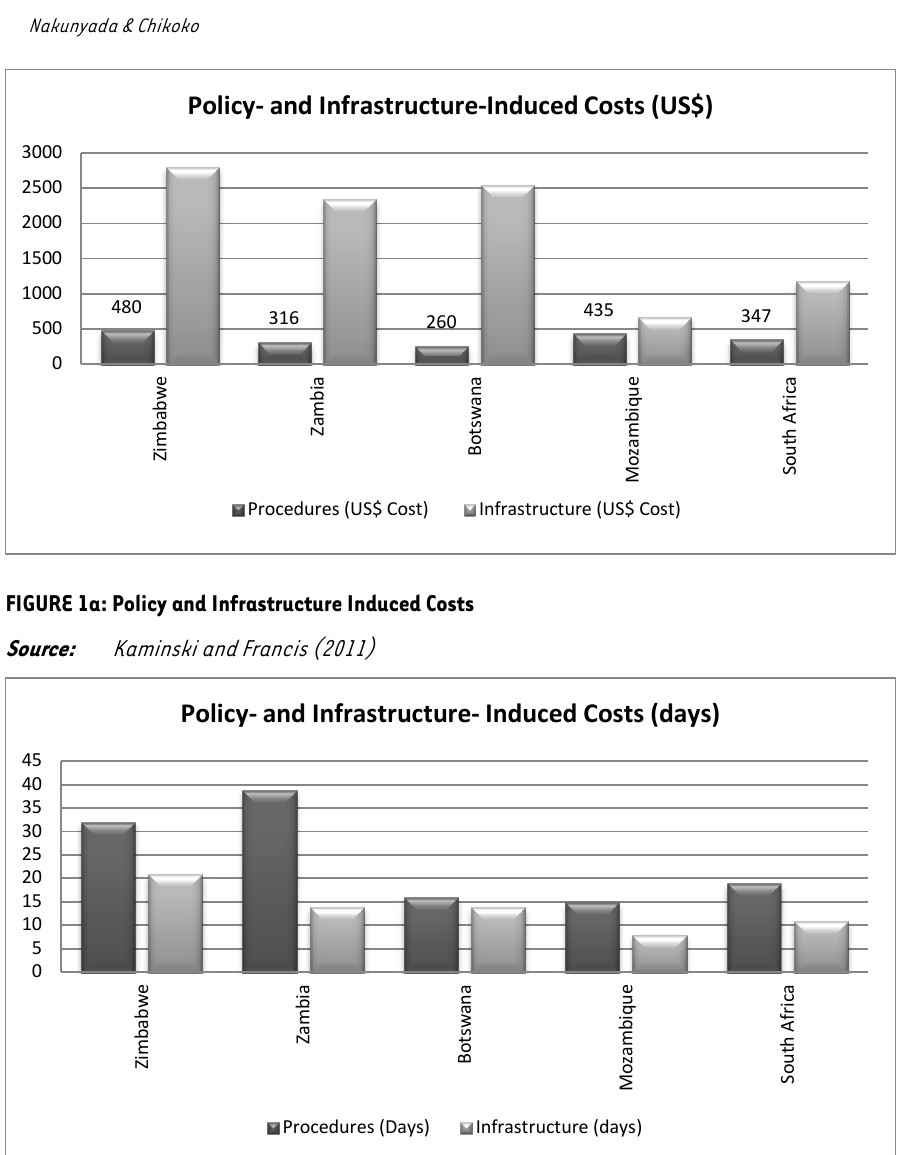
FIGURE 1b: Policy and Infrastructure Induced Costs Source: Kaminski and Francis